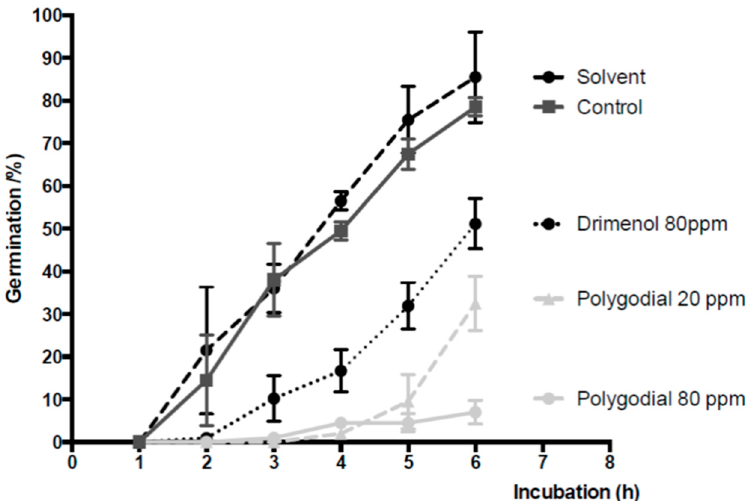
Figure 4. Effect of polygodial on conidial germination of B. cinerea . Plots represent percentage of germination of B. cinerea as a function of time in presence of polygodial, 20 ppm ( ▲ ) and 80 ppm ( ● ); and drimenol 80 ppm (- ● -) between 1 and 6 h post incubation. Final solvent concentration was identical in control and treatment assays. Each point represents the means of at least three independent experiments ± standard deviation. Drimenol data are from Robles-Kelly et al. [19].